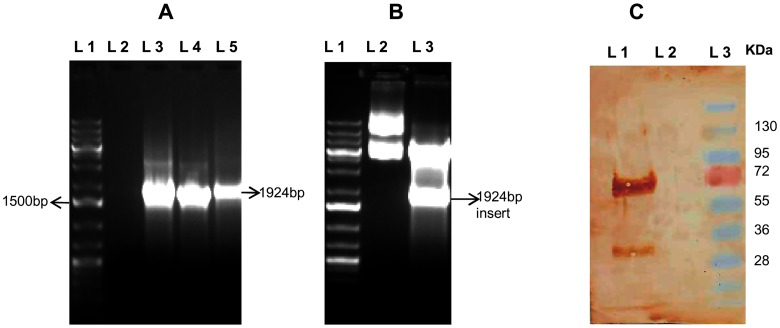
Cloning and expression of bm-myo in mammalian expression vector
(A) PCR amplification of bm-myo. Lanes L1: 1Kb+ DNA ladder; L3-L5: amplified gene product (B) Confirmation of bm-myo gene insert in pcDNA3.1(+) construct. Cloning in pcDNA was verified by digesting the plasmid construct with endonucleases BamHI and XhoI.Lane 1: 1kb+ DNA ladder; Lane 2: undigested plasmid; Lane 3: Bam HI and XhoI digested pcD-Myo plasmid construct (C) Expression of Bm-Myo in transfected Vero cell line was carried out by anti Bm-Myo antibody. Lane 1: Western blot of pcD-Myo transfected construct; Lane 2: Western blot of only pcDNA transfected vector in Vero cell line, Lane 3: Standard protein molecular weight marker.